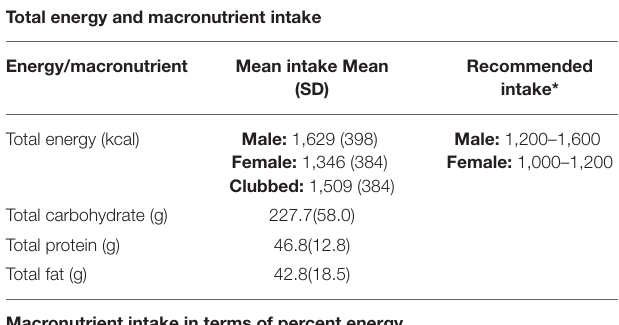
TABLE 2 | Energy and macronutrient intake and variation in